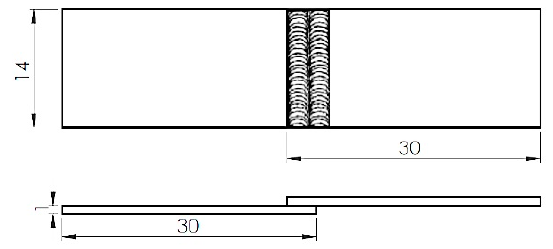
Figure 4. Schematic of the welding performed on the samples.